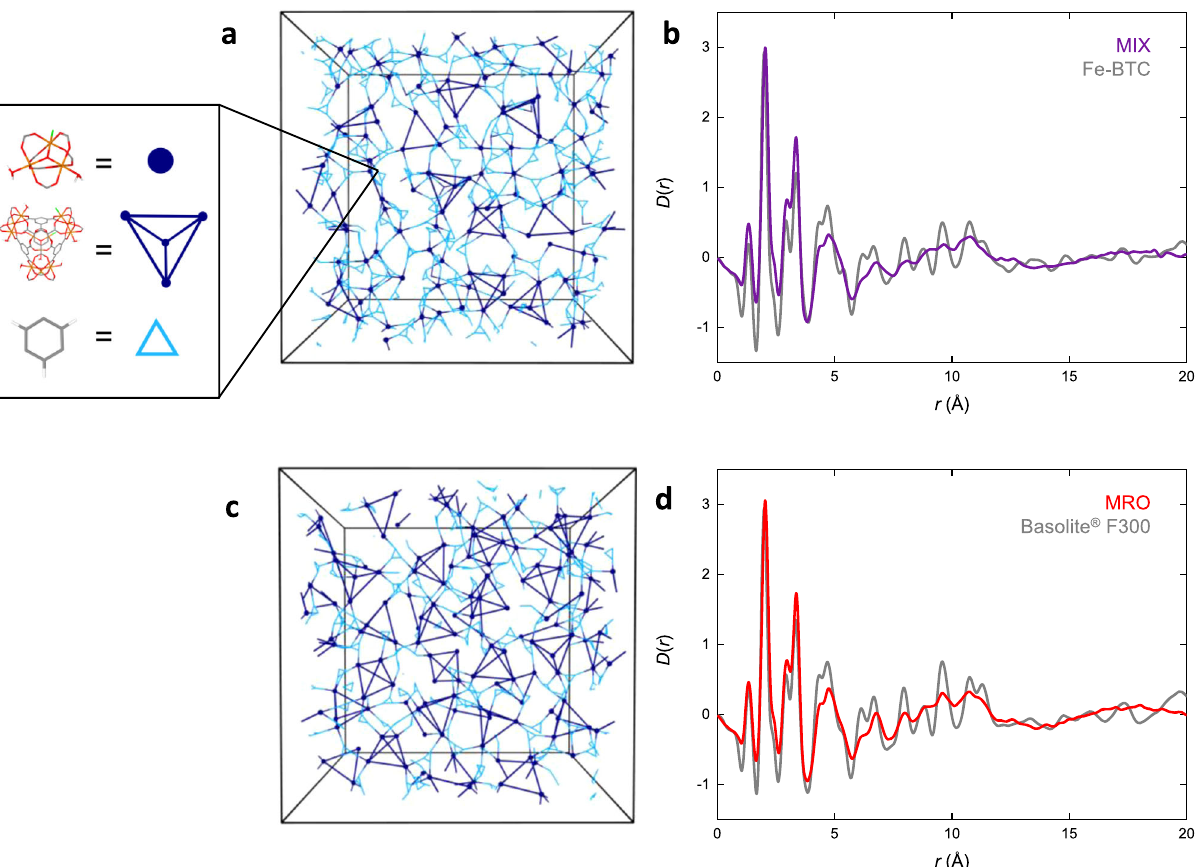
Fig. 4 Structure of Fe-BTC. a Schematic diagram of the MIX model. A representative 20 Å slice of the model is shown for clarity. Dark blue circles represent the centre of the trimer units. Trimer units within a tetrahedral assembly are connected via dark blue lines. Organic linkers connecting trimer units and tetrahedral assemblies (excluding those within the tetrahedra themselves) are shown as light blue triangles. Inset shows the relationship between the model and schematic. b Experimental X-ray PDF for Fe-BTC (grey) and calculated PDF for the MIX model (purple). c Schematic model of the MRO model. In the MRO model, all trimers are assembled into tetrahedra. d Experimental X-ray PDF for Basolite ® F300 (grey) and calculated PDF for the MRO model